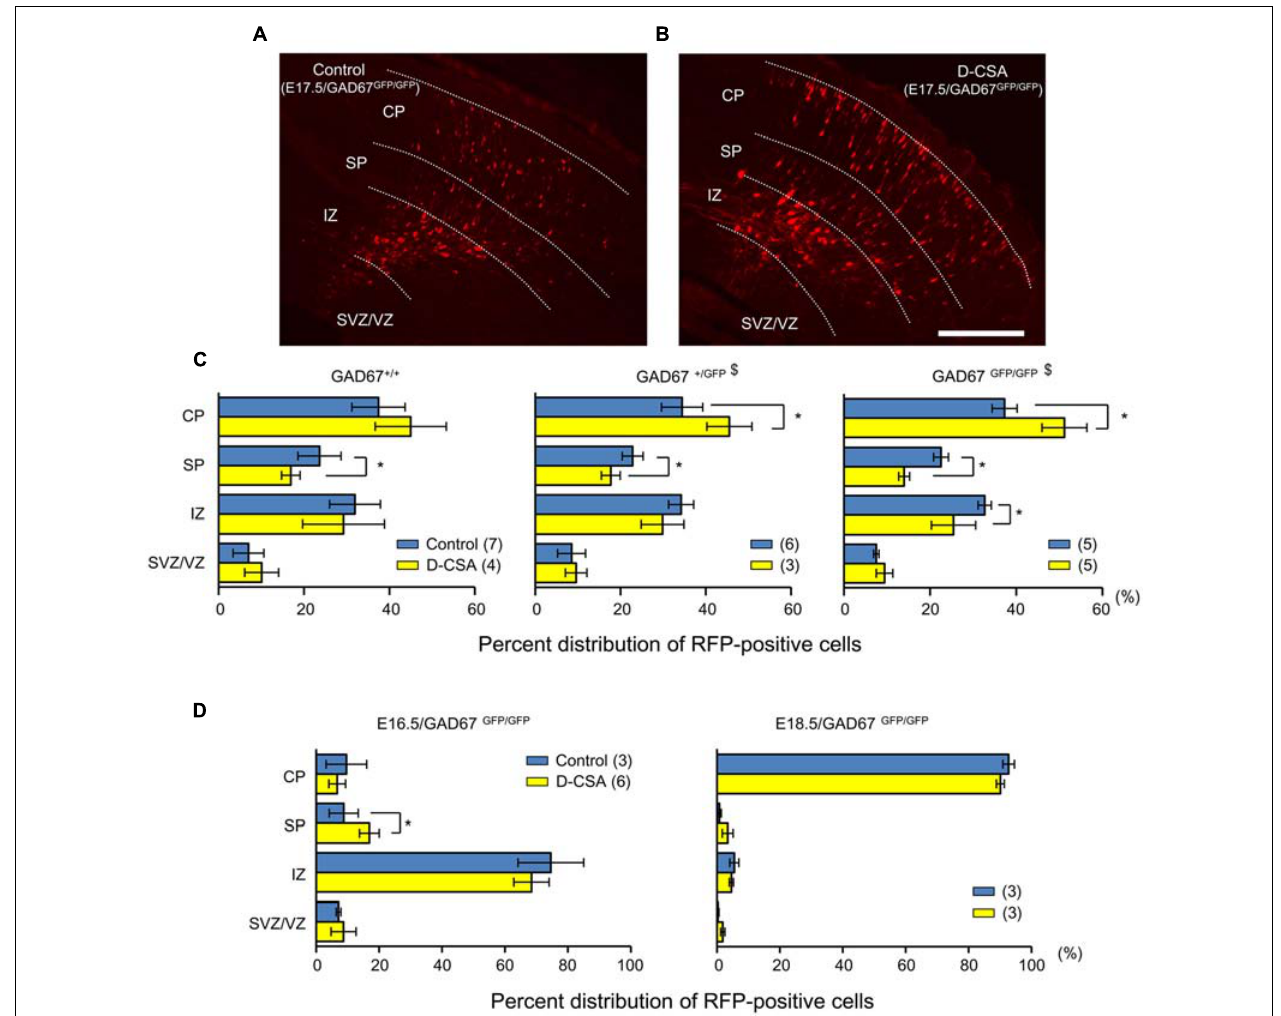
FIGURE 9 | Effects of maternal D-CSA administration on the distribution of radially migrating neurons in the fetal neocortex. (A,B) Fluorescent micrographs showing the distribution of RFP-labeled radially migrating cells in cortical sections from GAD67 GFP / GFP fetuses at E17.5. Saline (Control) (A) or D-CSA (B) was administered to the mothers every 12 h for 3 days (E14–17). (C) The averaged proportions of radially migrating cells in the CP, SP, IZ, and SVZ/VZ regions of cortical slices obtained from GAD67 + / + (leftmost),